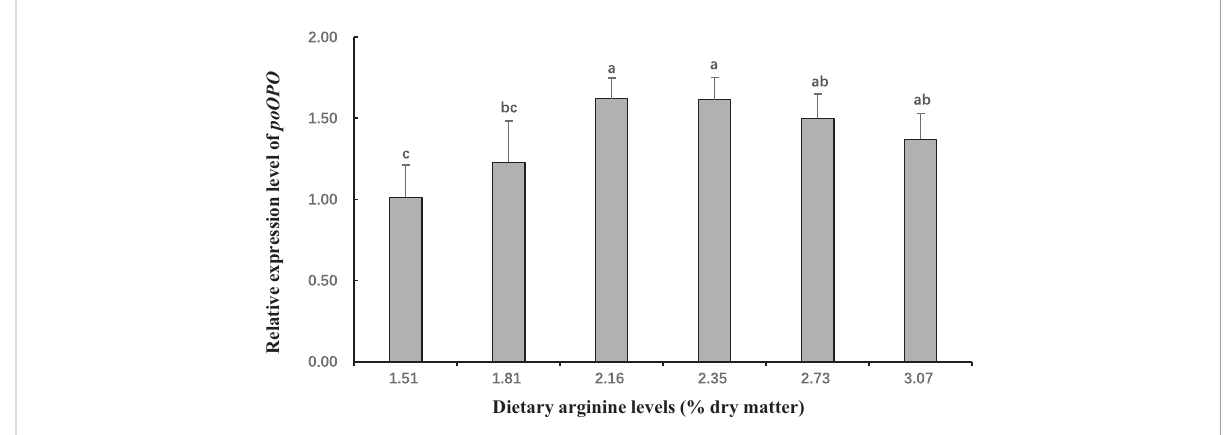
FIGURE 6 The gene expression (prophenoloxidase ( proPO ) in hepatopancreas) of postlarval Scylla paramamosain fed diet with different arginine levels. Means in the same row with different superscripts are signi fi cantly different (P< 0.05).